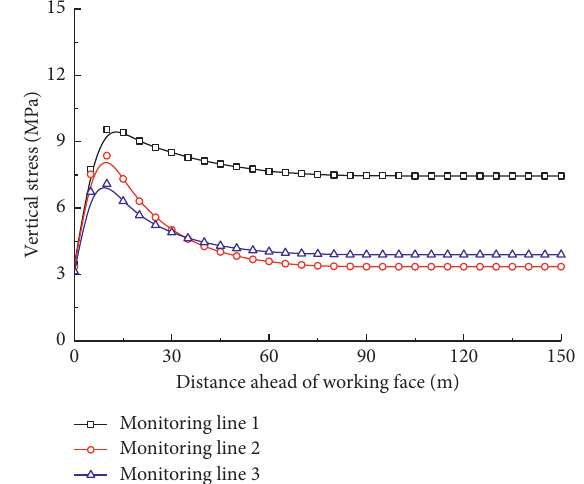
Figure 8: Stress distribution curves in front of the working